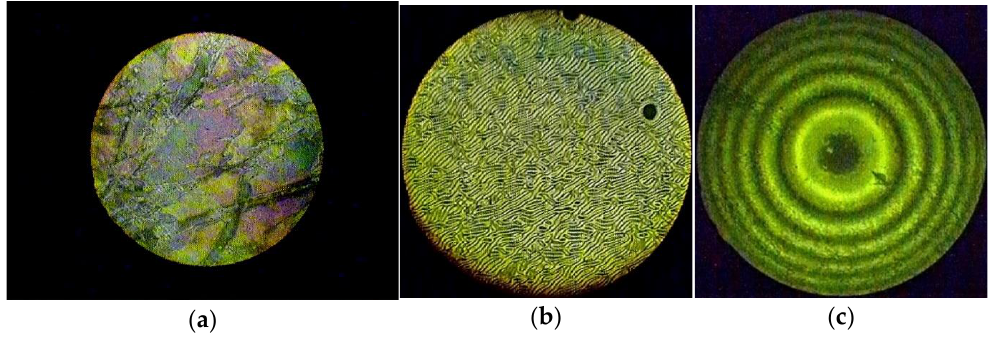
Figure 4. Marble texture of CB-2 at 70.1 °C ( a ). Fingerprint texture of CB-2 + 8.7% CPDA mixture at 45 °C ( b ) and Newton ’ s rings system of CB-2 + 5.263% CPDA mixture at 35.8 °C ( c ).